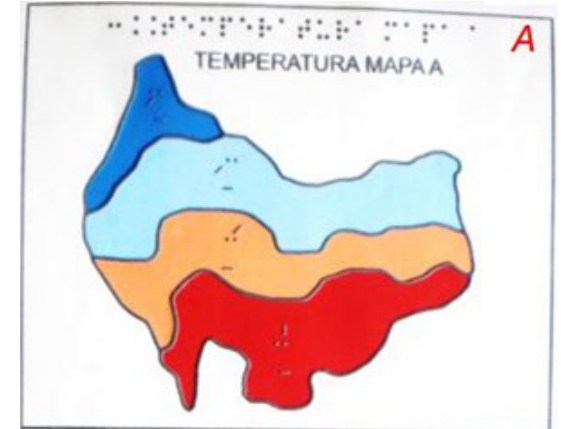
Figure 11. Map A, theme: Temperature, printed on special paper with divergent colors along with the tactile language of the See Color